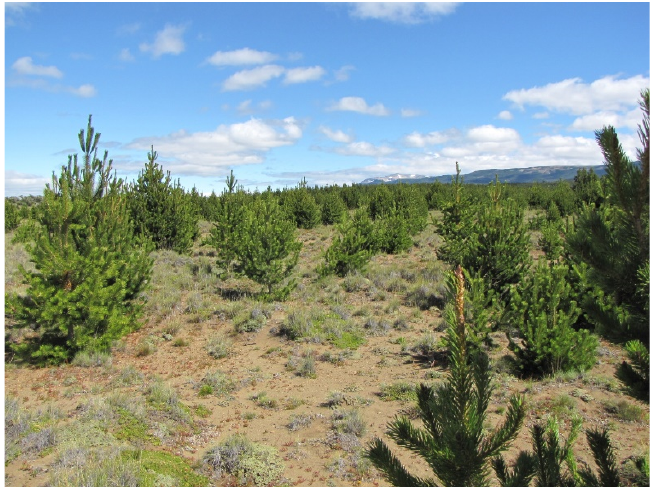
Figure 3. Invaded area selected to determine the influence of surrounding vegetation on Pinus contorta , located in the Patagonian Steppe of Coyhaique Alto (45° 30′ S and 71° 42′ W).